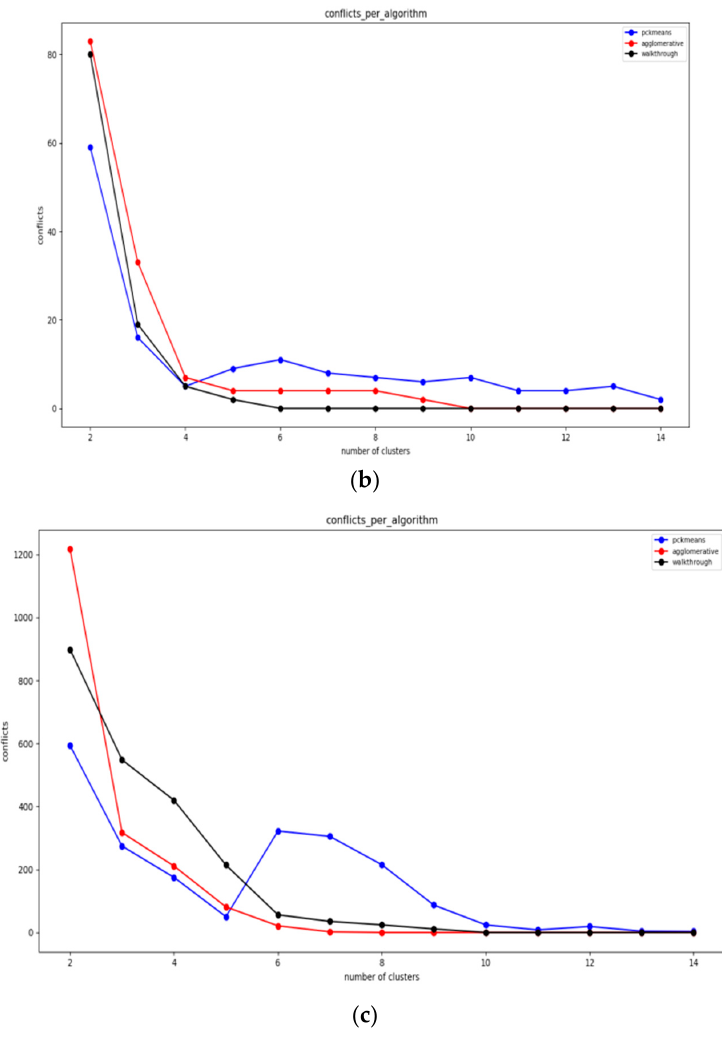
Figure 9. Evaluation results for static clustering over the topology of 123 nodes for ( a ) r s = 3, a = 2 and ann = 5.2, ( b ) r s = 1.5, a = 2 and ann = 3.5, ( c ) r s = 9, a = 8.2 and ann = 29.9.